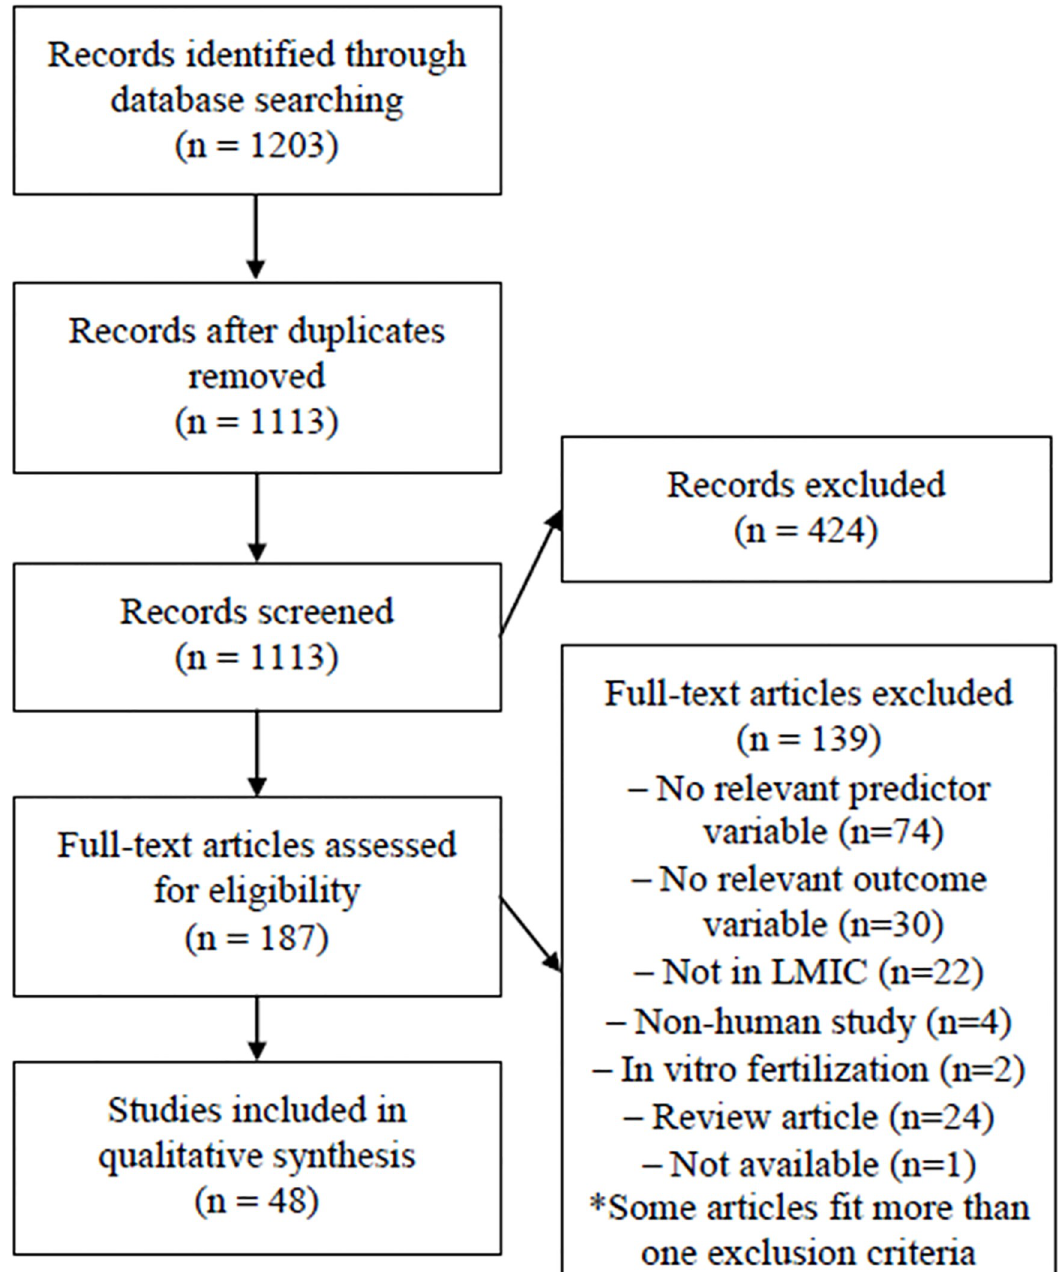
Fig 1. Flow diagram of search strategy and article